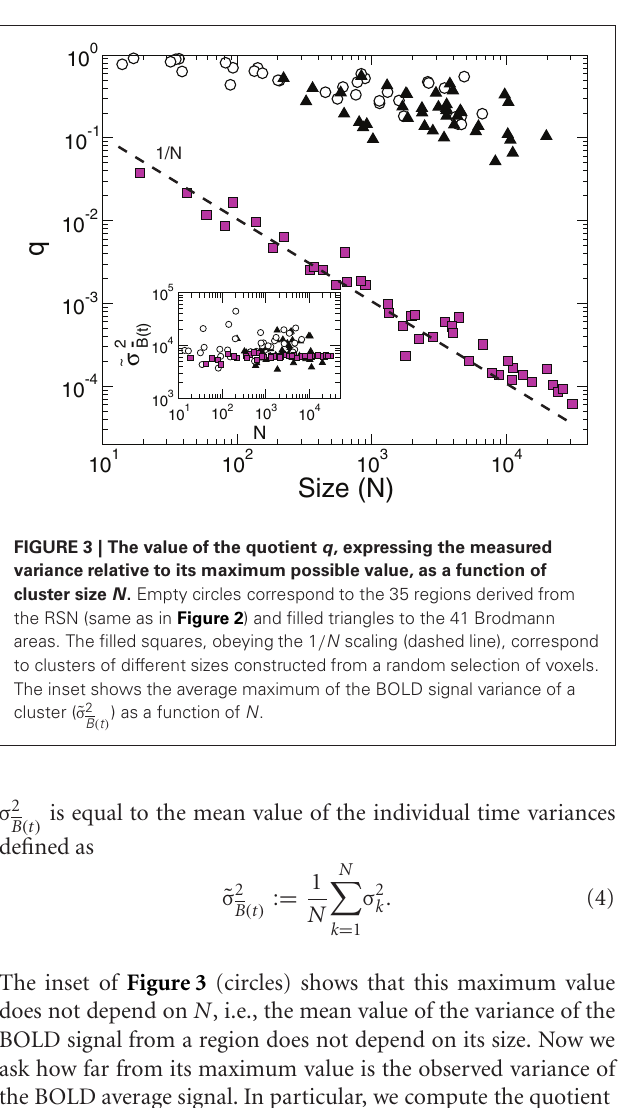
Table 1 | Z -threshold used in each independent component for defining the regions.